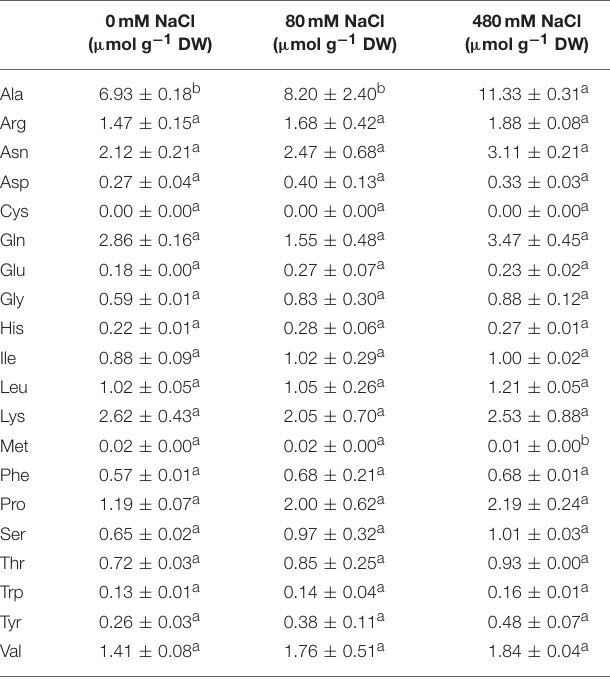
TABLE 5 | Effects of salinity stress on the free amino acid contents in the leaves of K. sieversiana .